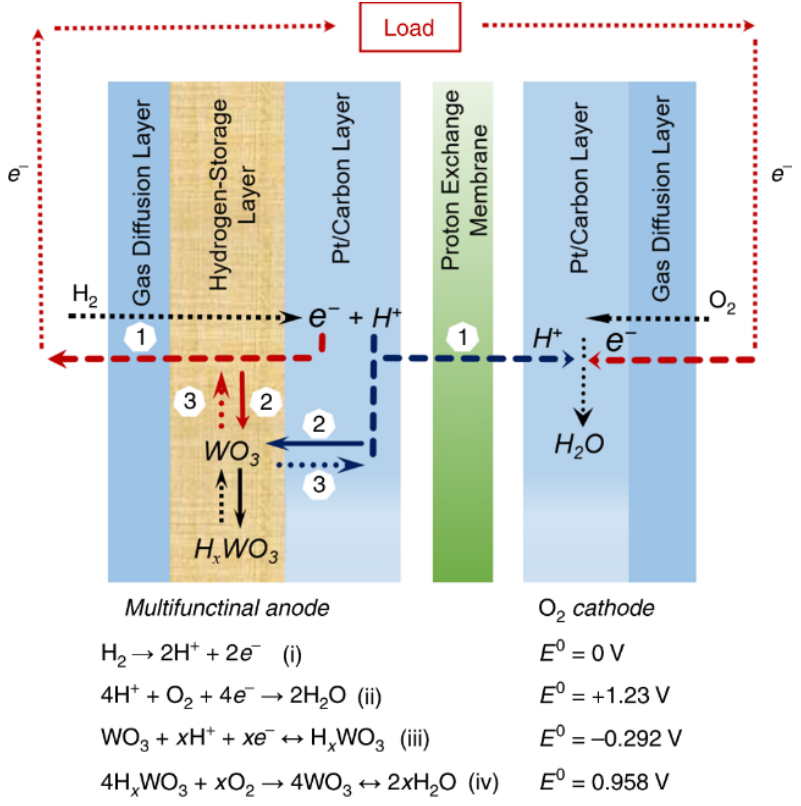
Figure 1. Operating characteristics for proton-exchange membrane fuel cells [6].